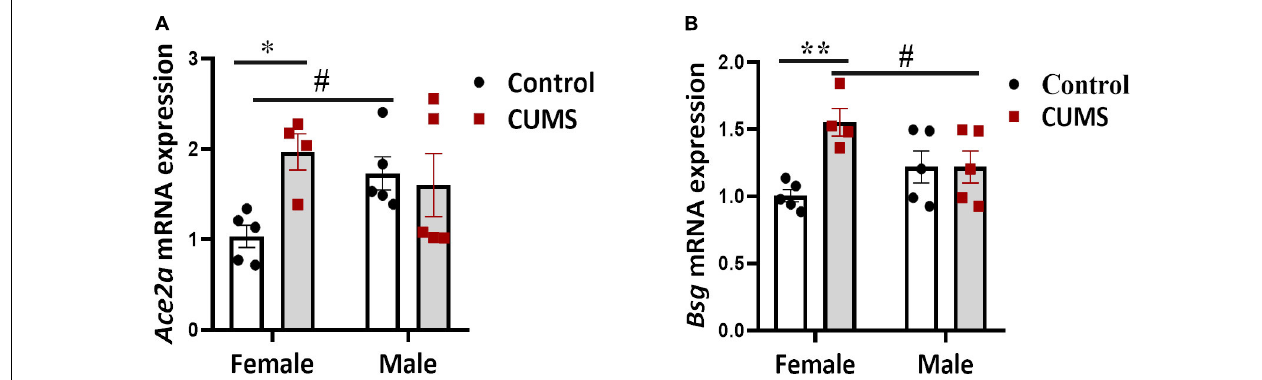
FIGURE 4 | SARS-CoV-2 receptors were upregulated in the PFC of female mice. Sex-dependent upregulations of Ace2a (A) and Bsg (B) were detected using RT-qPCR. The symbols * and # represent CUMS and sex differences, respectively (two-way ANOVA). ∗ p < 0.05, ** p < 0.01, and # p < 0.05.